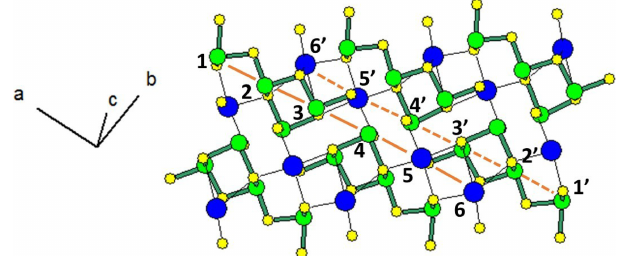
Figure 2. Projection of the SnS-type, two-atom-thick ribbon of the crystal structure of fülöppite, according to Nuffield (1975). Two symmetric oblique cation rows alternate (1 to 6, and 1 (cid:48) to 6 (cid:48) ), with the sequence Sb–Sb–Sb–Sb–Pb–Pb. Short Sb–S bonds have been highlighted in